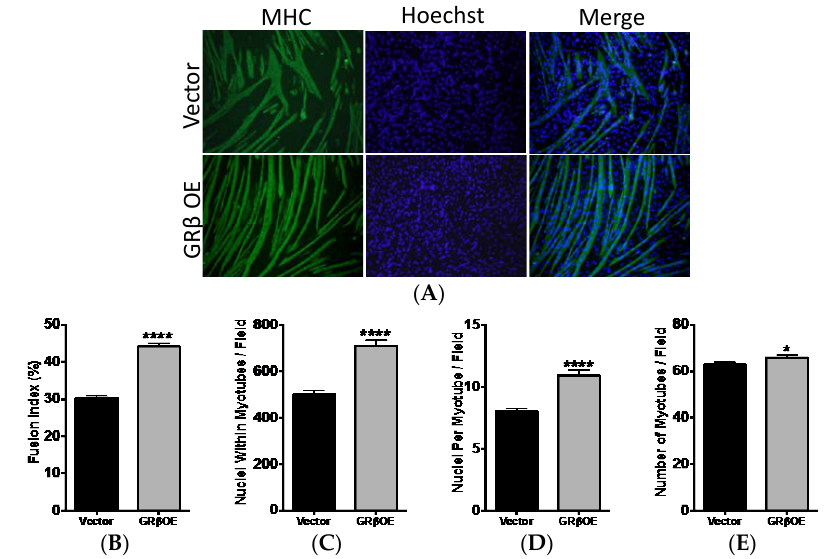
Figure 5. GRβ overexpression enhances fusion and myotube formatio n. ( A ) Myoblast fusion and myotube formation was assessed in vector and GRβOE cells using myosin heavy chain (MHC) labeling following four days of differentiation. Myotubes were identified as MHC+ cells with a minimum of two nuclei; ( B ) The fusion index; ( C ) total nuclei within myotubes; ( D ) nuclei per myotube; ( E ) the number of myotubes, were all significantly greater in GRβOE cells. * p < 0.05, and **** p < 0.0001 compared to vector. n = 6 to 9 experiments. 5 to 7 fields were analyzed per experiment by blinded investigators. All images analyzed at 10× magnification. Data expressed as mean ± SEM .